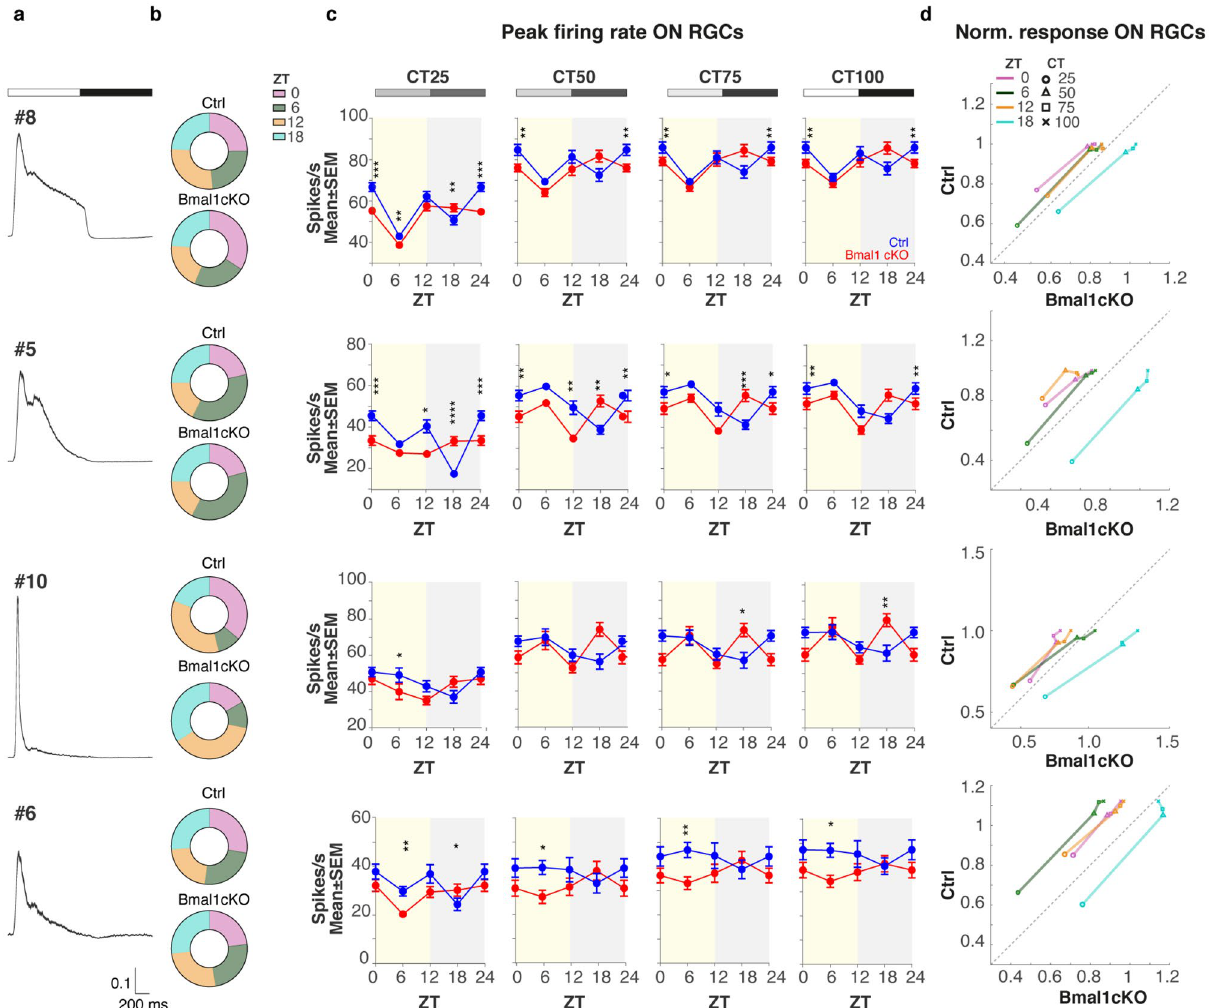
Figure 5. Bmal1 deletion affects ON RGCs maximum firing rate in response to light in mesopic conditions. (a) Averaged normalized PSTH (mean ± SEM) of all RGCs belonging to the most abundant ON clusters (both genotypes, all ZTs at CT100) #8, #5, #10, and #6 in response to full-field white-black alternating flashes (stimulus indicated above). (b) The proportion of recorded RGCs per ZTs (Top, Ctrl and bottom, Bmal1 cKO). All cells from different experiments pulled together. (c) Analysis of the maximum firing rate in response to alternating bright and dark flashes performed on selected ON RGCs clusters (different rows) at four different ZTs (0, 6, 12, 18) and different contrasts (CTs, different columns). Data are shown as mean ± SEM between cells belonging to a specific cluster, separately for Ctrl (blue) and Bmal1 cKO (red). Asterisks mark a significant difference between groups. (Kolmogorov–Smirnov test; *P < 0.05, **P < 0.01, ***P < 0.001, ****P < 0.0001). (d) Scatter plots of RGCs peak amplitudes normalized to the maximal response of the control throughout the day in Ctrl (y-axes) vs. Bmal1 cKO (x-axes) conditions. Different colors indicate results obtained at diverse ZTs, and the symbols denote contrast conditions. Dashed line: unity